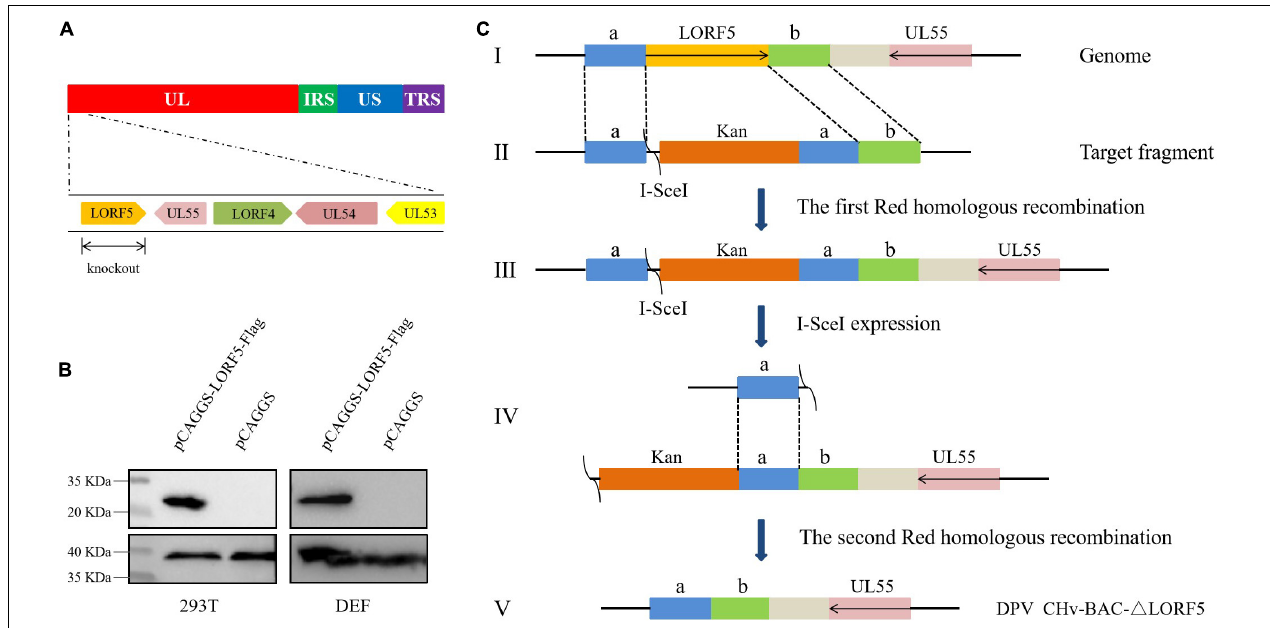
FIGURE 1 | Schematic diagram of CHv-BAC- (cid:49) LORF5 construction. (A) DPV genome structure. (B) Detection of protein expression of LORF5 gene in eukaryotic plasmid-transfected cells by western blotting. 293T and DEF cells were transfected and harvested at 24 hpi (293T) and 36 hpi (DEF cells). Proteins were detected using a mouse anti-FLAG MAb. (C) The principle of knocking out the DPV LORF5 gene. In the first step of homologous recombination, the LORF5 gene was replaced by the Kan resistance gene through 40-bp homology arms (sequences a and b). In the second step, L -arabinose induced recombinase to recognize the I- Sec I cleavage site and delete the Kan fragment. Then, the LORF5 gene ORF was deleted in the DPV genome without any